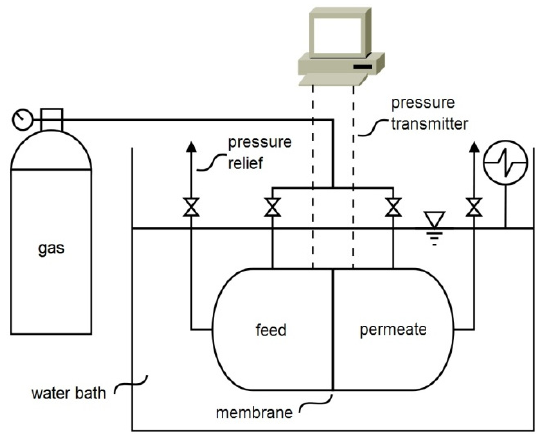
Figure 3. Experimental set-up for measuring the permeability of the membranes for a single